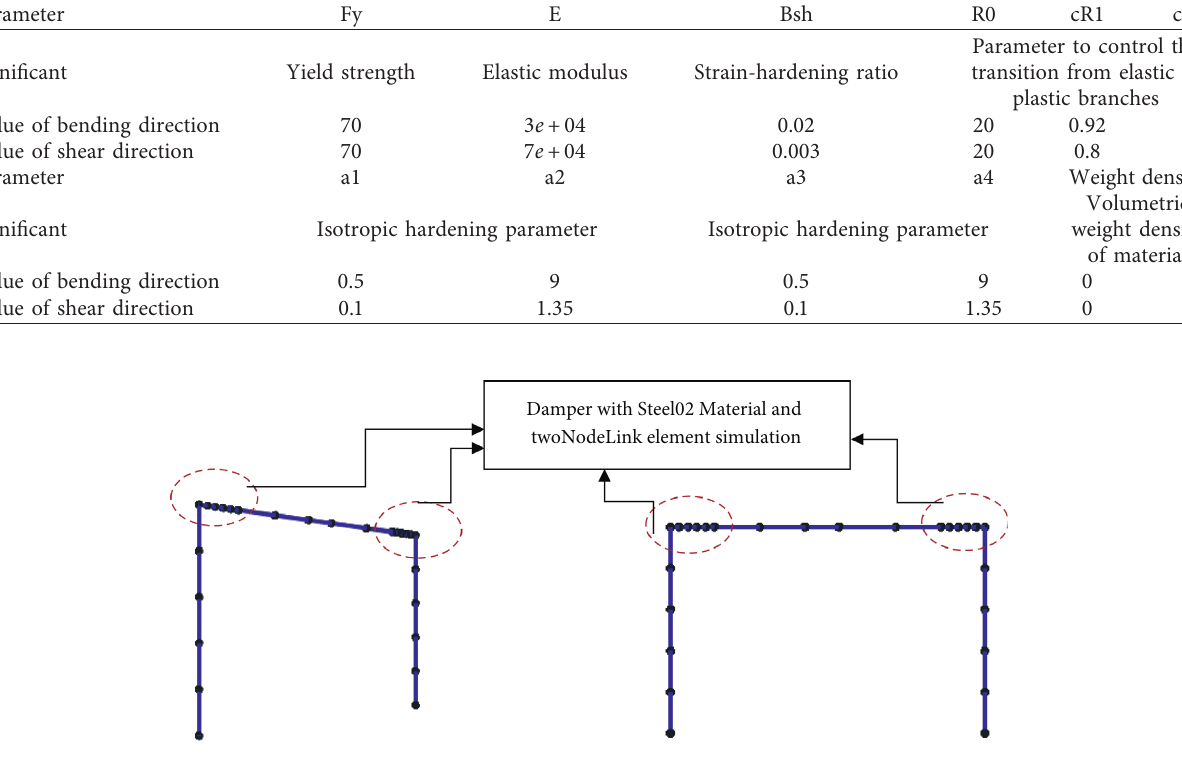
Figure 12: Single-story-and-span frame model in OpenSees.